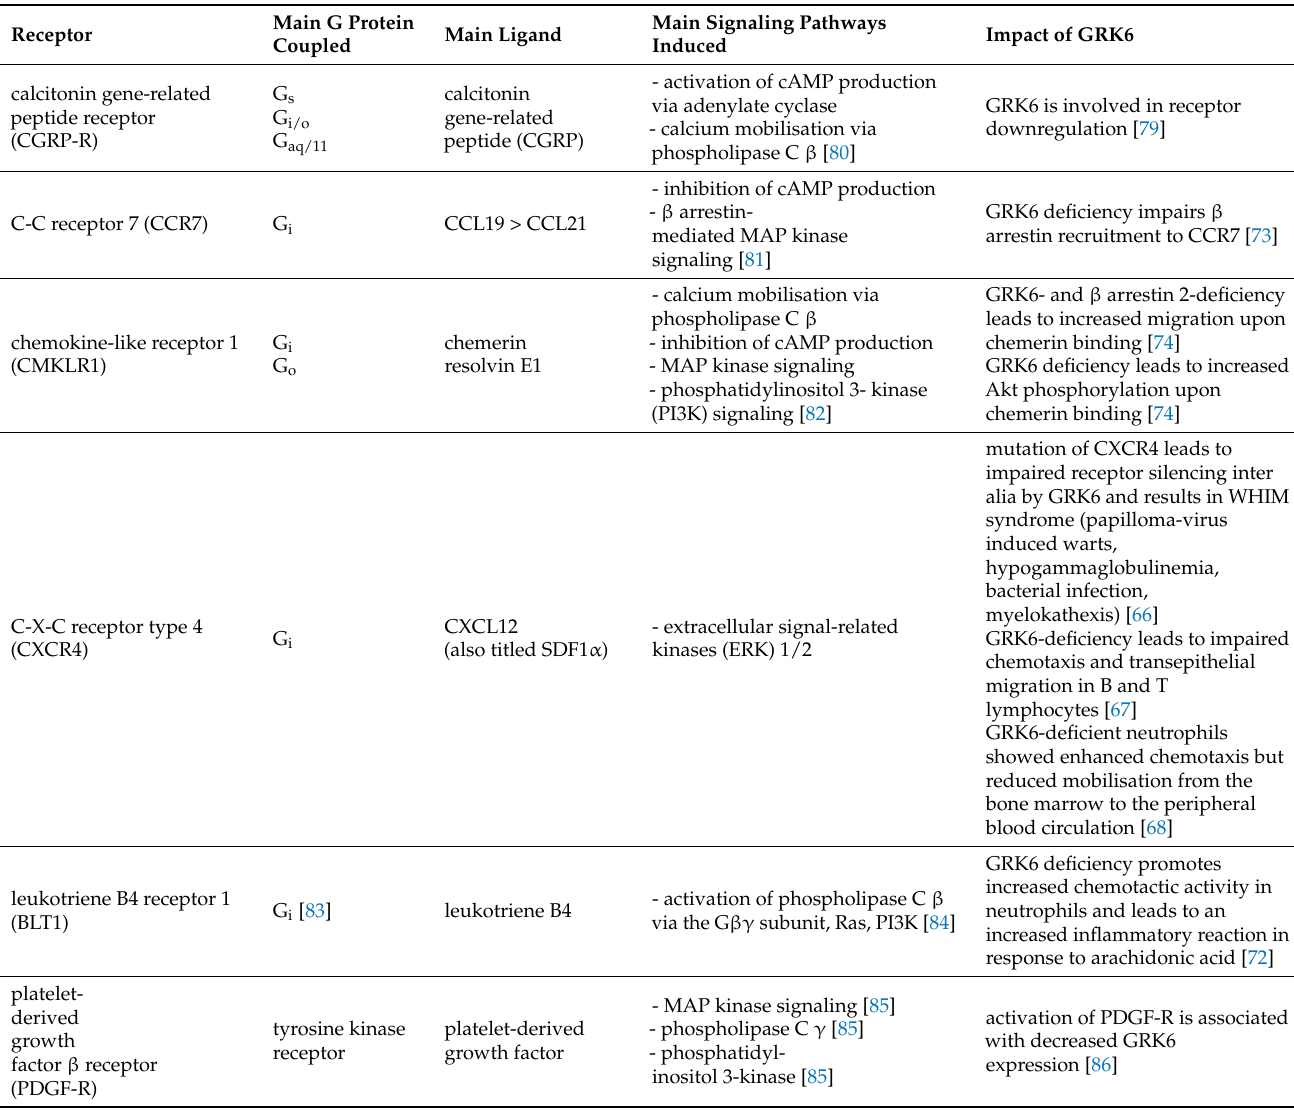
Table 1. GPCRs and their interaction with